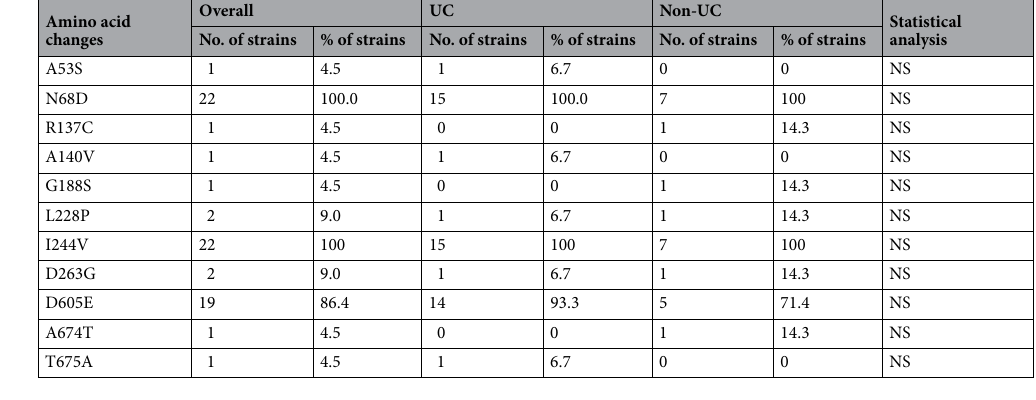
Table 4. Amino acid changes related to UL97 mutations and polymorphisms in 22 Japanese patients with colonic CMV infection in comparison with AD169 reference strain.